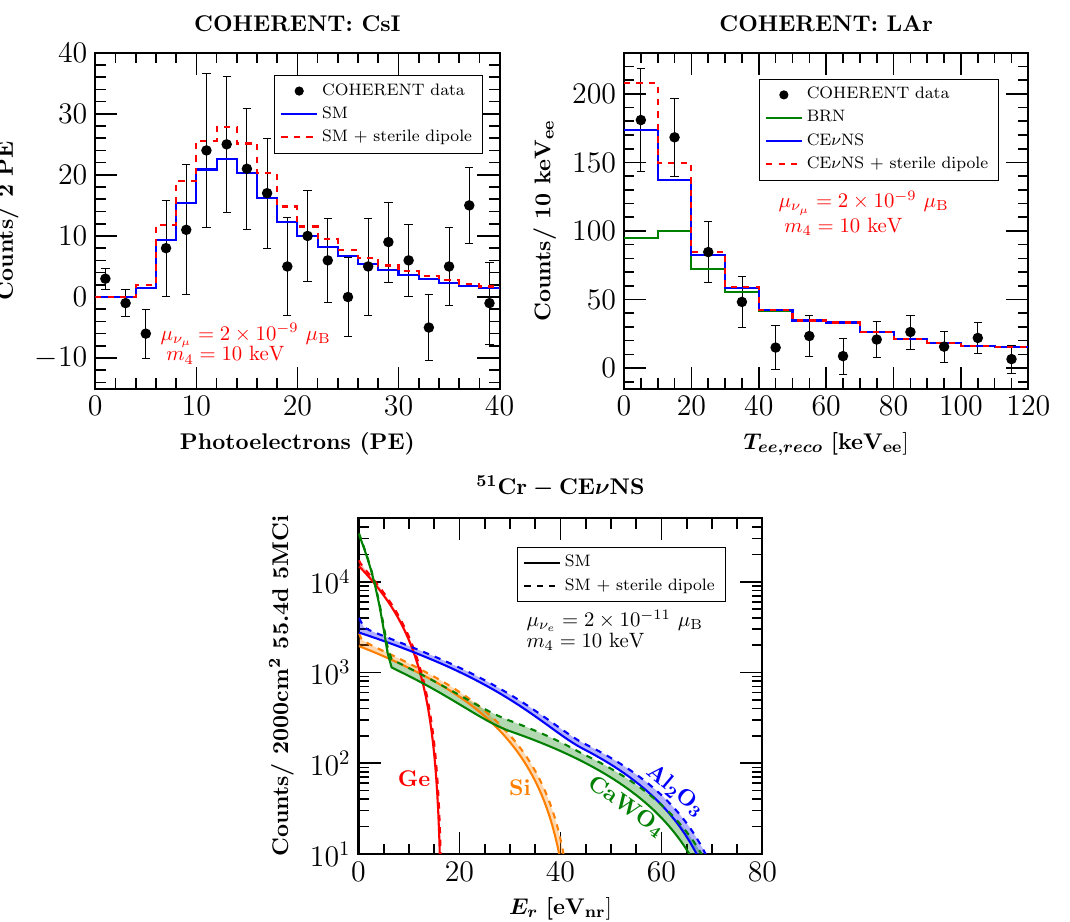
Figure 2 . Signal at COHERENT-CsI detector (top left) , COHERENT-LAr detector (top right) assuming a transition magnetic moment µ ν (bottom ) assuming a transition magnetic moment µ ν sterile neutrino with mass m 4 =10